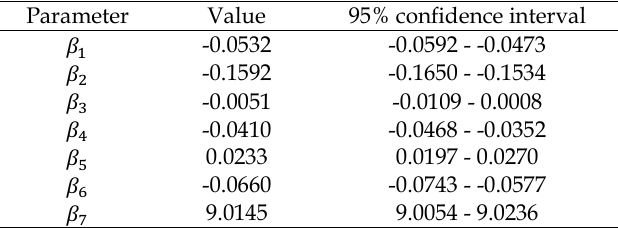
Table B1. Deterministic parameters calculated with daily flights 2014-2017